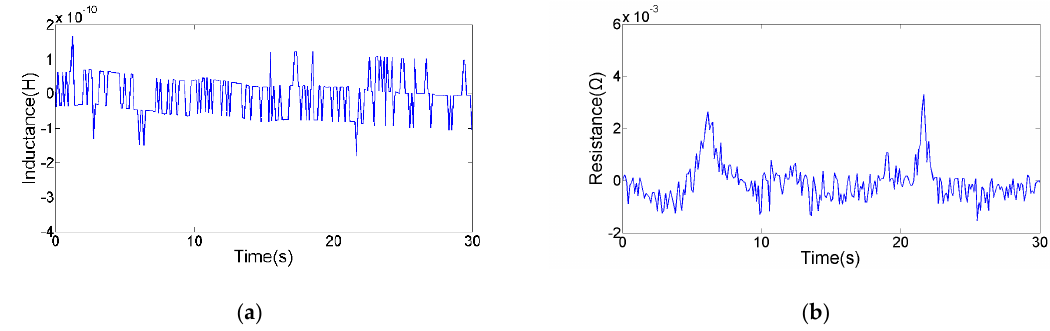
Figure 9. The detection result of a 65 μ m copper particle: ( a ) the inductance signal; ( b ) the resistance signal.